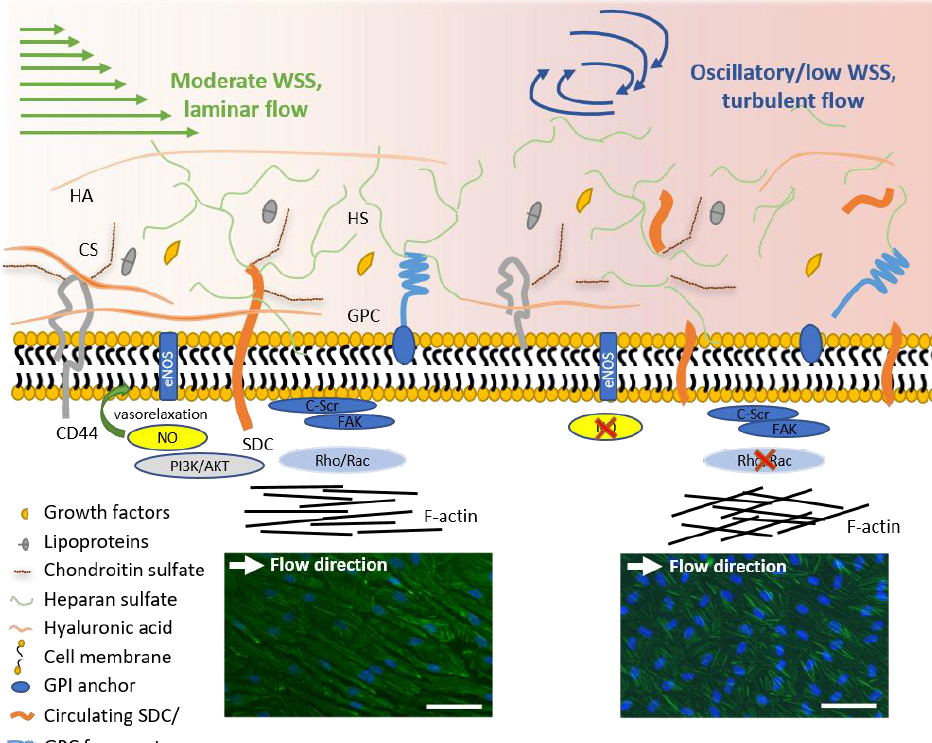
Figure 2. GCX signaling under different WSS conditions. Shedding of the eGCX occurs under low or oscillatory WSS with turbulent flow, thereby affecting different intracellular signaling pathways, e.g., NO-synthase and cytoskeleton arrangement. Microphotographs of immunofluorescence staining show human umbilical vein ECs after 24 h of laminar (left) or non-uniform, turbulent (right) flow. Nuclei are stained in blue (DAPI) and F-actin is stained in green (phalloidin Alexa Fluor 488). Scale bar: 100 µm; AKT: protein kinase B, CS: chondroitin sulfate, eNOS: endothelial nitric oxide synthase, GPC: glypican, HA: hyaluronic acid, HS: heparan sulfate, NO: nitric oxide, c-Scr: proto-oncogene tyrosine-protein kinase Src, FAK: focal adhesion kinase, PI3K: phosphoinositide-3phosphate, Rac: Ras-related C3 botulinum toxin substrate, RhoA: Ras homolog family member A, SDC: syndecan.